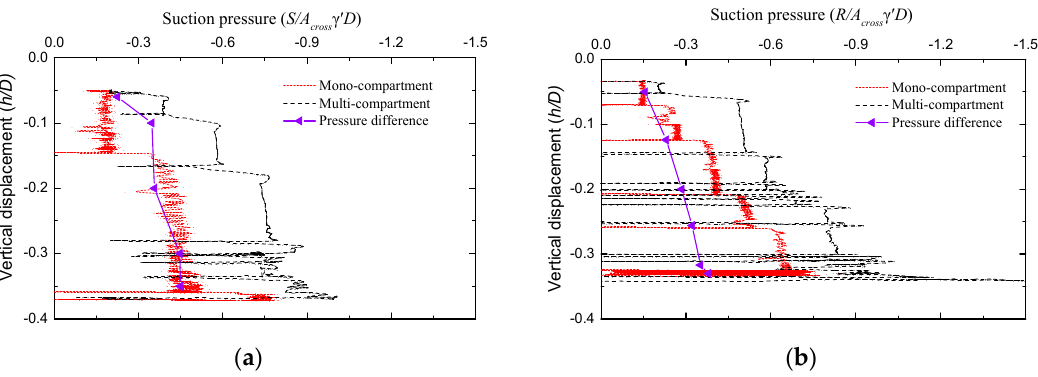
Figure 12. Effects of inner skirt plates and bulkheads on penetration resistance. ( a ) PS1-1 and PS2-1; ( b ) PS1-2 and PS2-2.